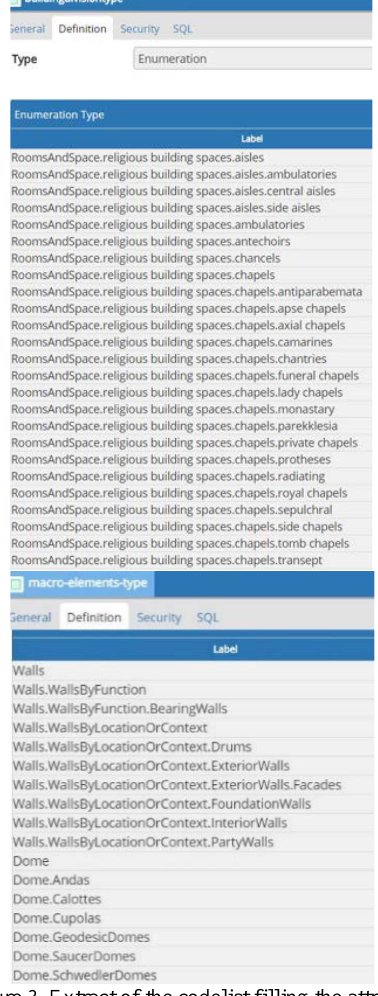
Figure 3. Extract of the codelist filling the attribute buildingdivision_type’ and ‘macroelement_type’, derived